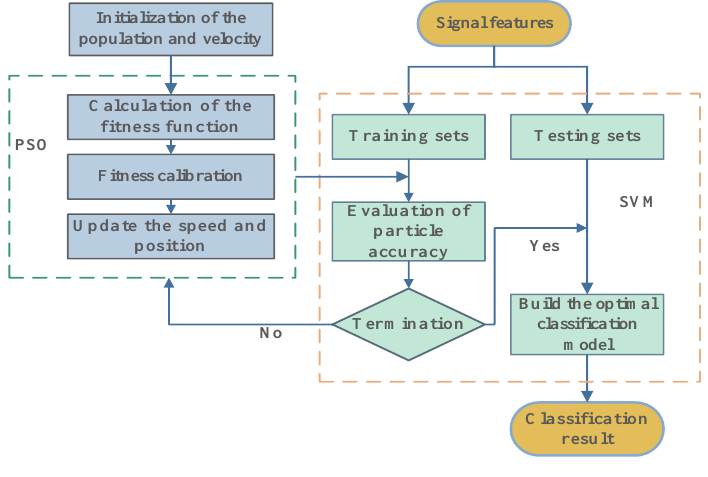
Figure 2. Flow chart of PSO-SVM.